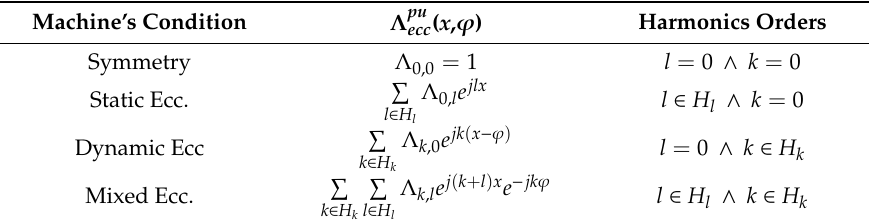
Table 1. Permeance function for di ff erent types of